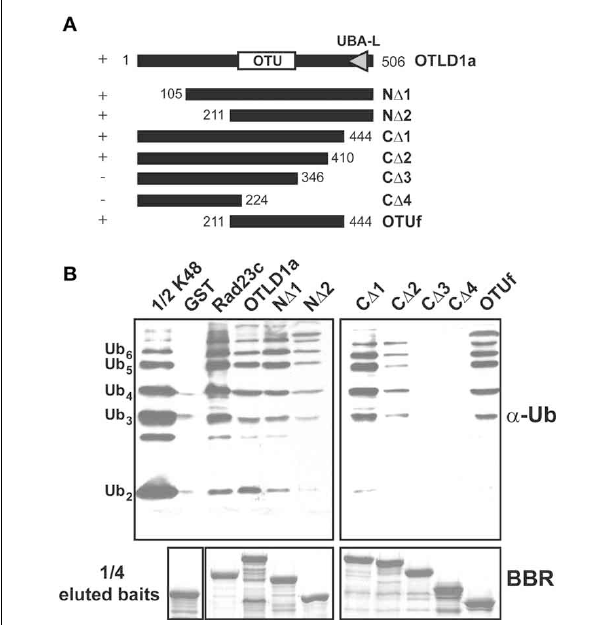
FIGURE 9 | The OTLD1a region spanning 211–410 but not the UBA domain is critical for UB chain binding. (A) Schematic diagrams show the OTLD1a deletion variants that were used to delineate the domain involved in UB chain binding. The OTU and UBA-like (UBA-L) domains are indicated. Positive and negative binding activity against K48-linked UB chains are indicated by + and − on the left. The numbers indicate the OTLD1a variant termini coordinates. (B) Pull-down products of the GST-fused OTLD1a variants. Five micrograms of K48-linked UB chains (2–6 units, labeled on the left) were subject to pull down by GST-fused OTLD1a variants and negative and positive control proteins (GST and AtRAD23c, respectively). One microgram of the input chains (1/2 K48) and two-fifths of the eluted pulled-down products were analyzed by immunoblotting with α -Ub. One-tenth of the eluted pulled-down products (1/4 eluted baits) were visualized by Brilliant Blue R staining (BBR) to confirm equivalently immobilized